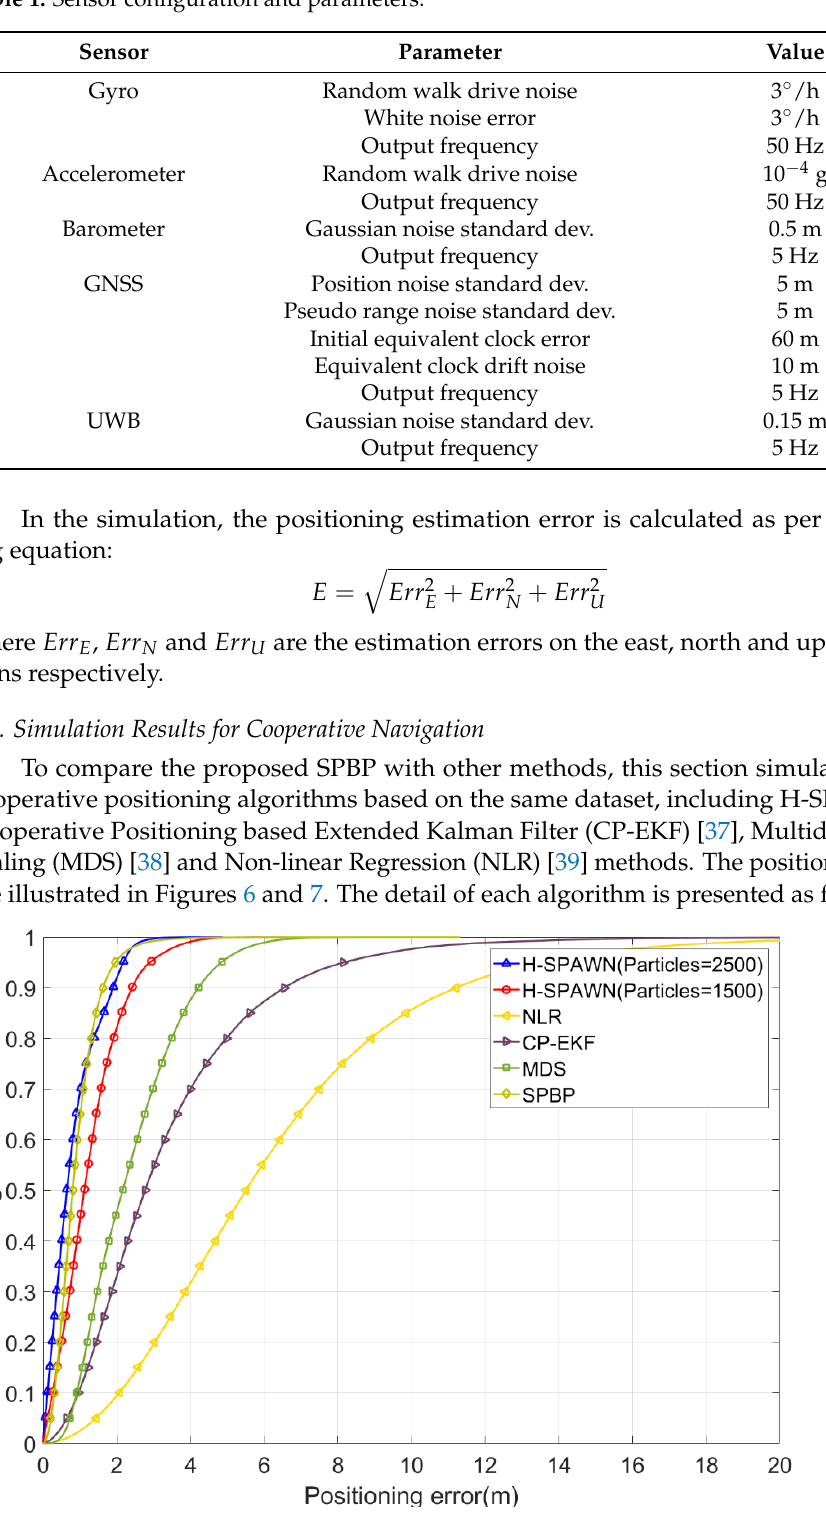
Figure 7. The example performance of positioning error for a single UAV: H-SPAWN (particle num- ber = 2500), H-SPAWN (particle number = 1500), NLR, CP-EKF, MDS, SPBP. Figure 6 presents the simulation results of several cases, where the cumulative distri- bution functions (CDF) of position errors for all UAVs are used as the performance met- rics. Figure 7 provides the example performance of a single UAV without satellite position measurement. NLR is a cooperative positioning method merely depending on the geo- metric relationship of UAV swarm and its precision is obviously lower than other coop- erative methods as shown in the figure. CP-EKF integrates the navigation information of IMU, barometer, GNSS, and adjacent UAVs. However, without iterative update, the